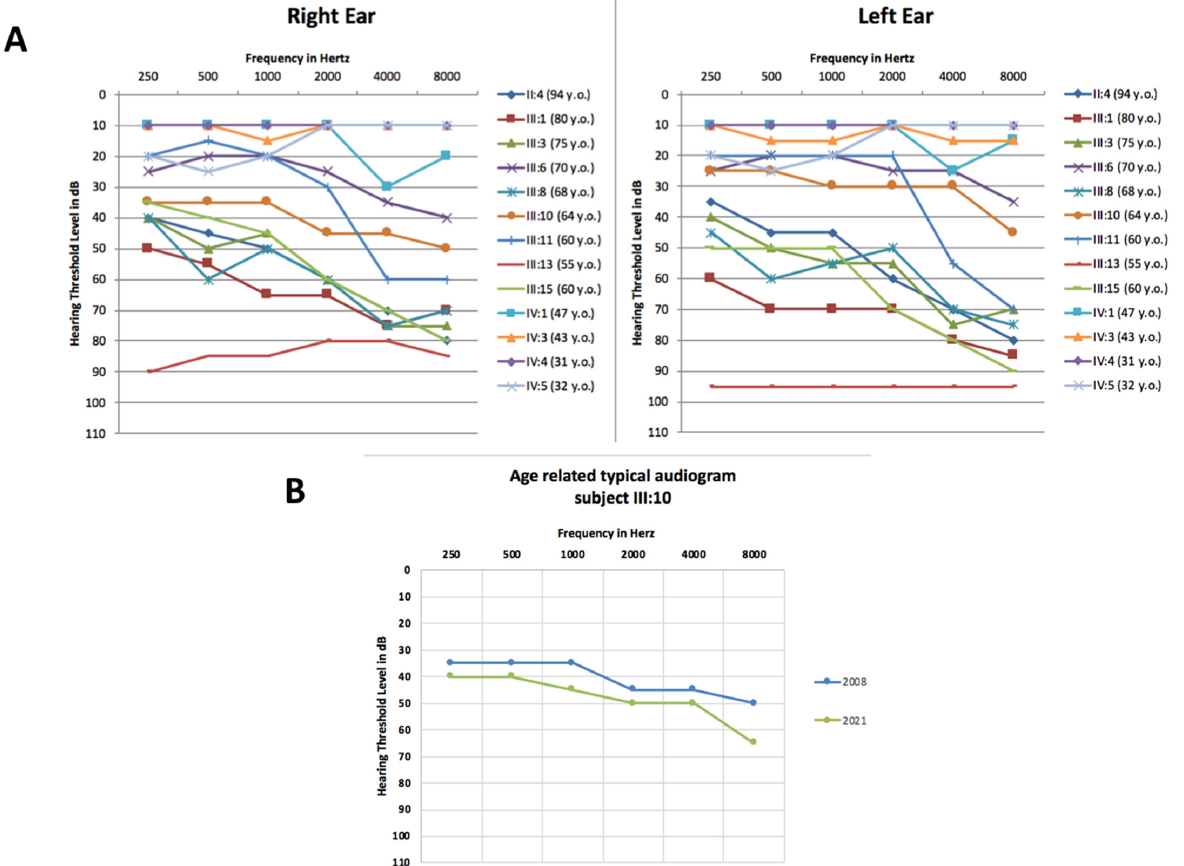
Figure 2. Audiograms of the Italian family. ( A ) Audiometric features, displayed as audiograms, were available for twelve members of the family. The thresholds of the right and left ears are shown for each patient. The audiometric patterns for patients IV:3 and IV:4 partially overlap. ( B ) Example of the progression of the hearing loss for patient III:10. In blue is displayed an audiogram performed in 2008, and in green, one of 2021 (Age-Related Typical Audiogram (ARTA)). Only the data for the best ear are reported. Table 1. Next-generation sequencing data. Data relative to ES for each patient. The bold character highlights to which patient the data presented refers